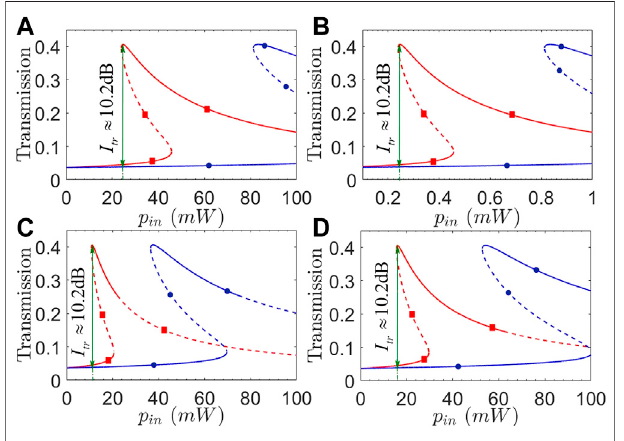
FIGURE 5 | (Color online) Transmission coef fi cients T 31 (red squares) and T 13 (blue circles) against detuning Δ 1 with (A) p in (cid:1) 0.1 mW; (B) p in (cid:1) FIGURE 3 | (Color online) Transmission coef fi cients T 31 (red squares) 20 mW; (C) p in (cid:1) 40 mW; (D) p in (cid:1) 50 mW. Solid and dashed parts of each and T 13 (bluecircles)againstinputpower p in with (A) g /2 π (cid:1) 0.9 MHz; (B) g /2 π curve refer to stable and unstable regions, respectively. Other (cid:1) 9.0 MHz; (C) ω π (cid:1) 4.5 GHz; (D) ω π (cid:1) 6.5 GHz. Solid and dashed m /2 m /2 parameters are Δ 2 /2 π (cid:1) 4.5 GHz, Δ 3 /2 π (cid:1) 1.5 GHz, g /2 π (cid:1) 0.9 MHz, ω m /2 π (cid:1) parts of each curve refer to stable and unstable regions, respectively. 10 GHz, J 12 /2 π (cid:1) 3.0 GHz, and J 23 (cid:1) 1.0 GHz, except those at the beginning Other parameters are the same as in Figure 2 , except J 23 /2 π (cid:1) 1.0 GHz. of Section 3